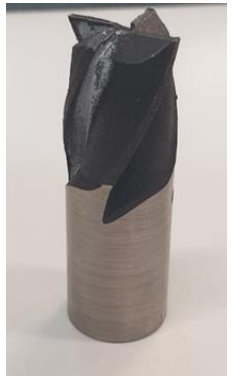
Figure 6. General view of the 3D printed tool.